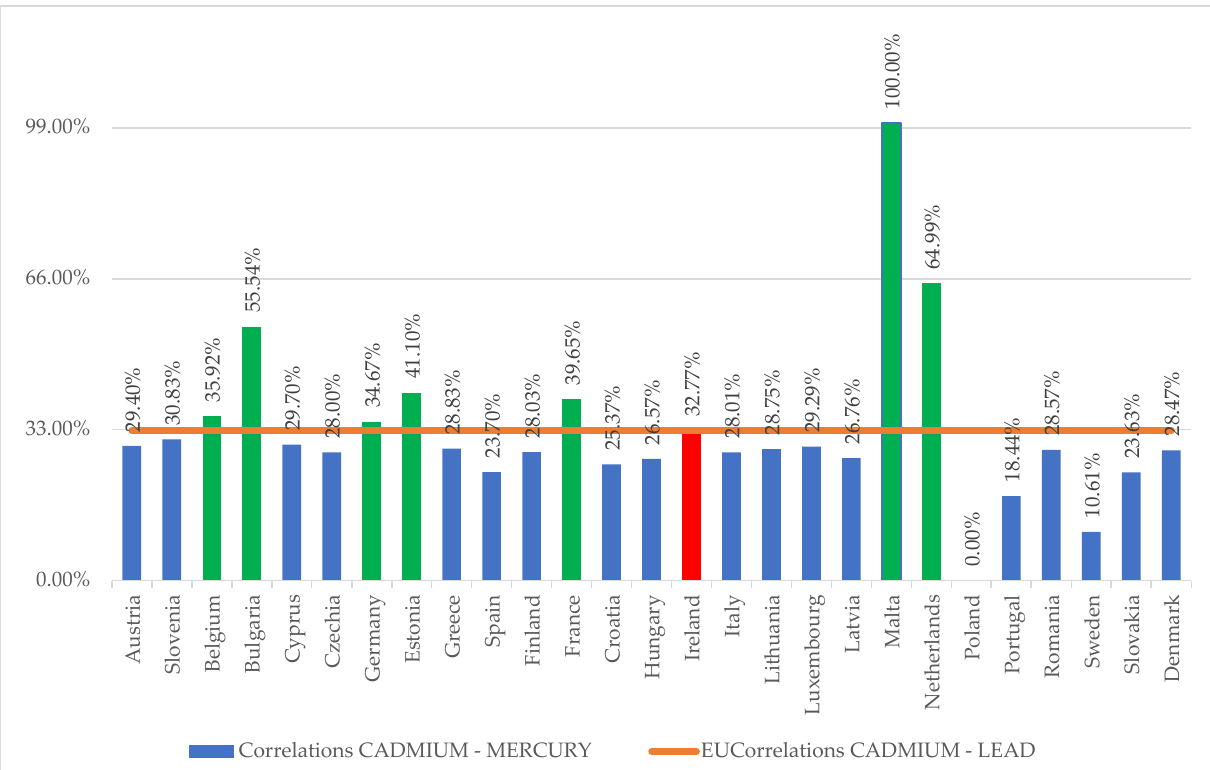
Figure 4. Evaluation of the degree of contribution of the particular model to the overall output of cadmium and mercury water pollution control.